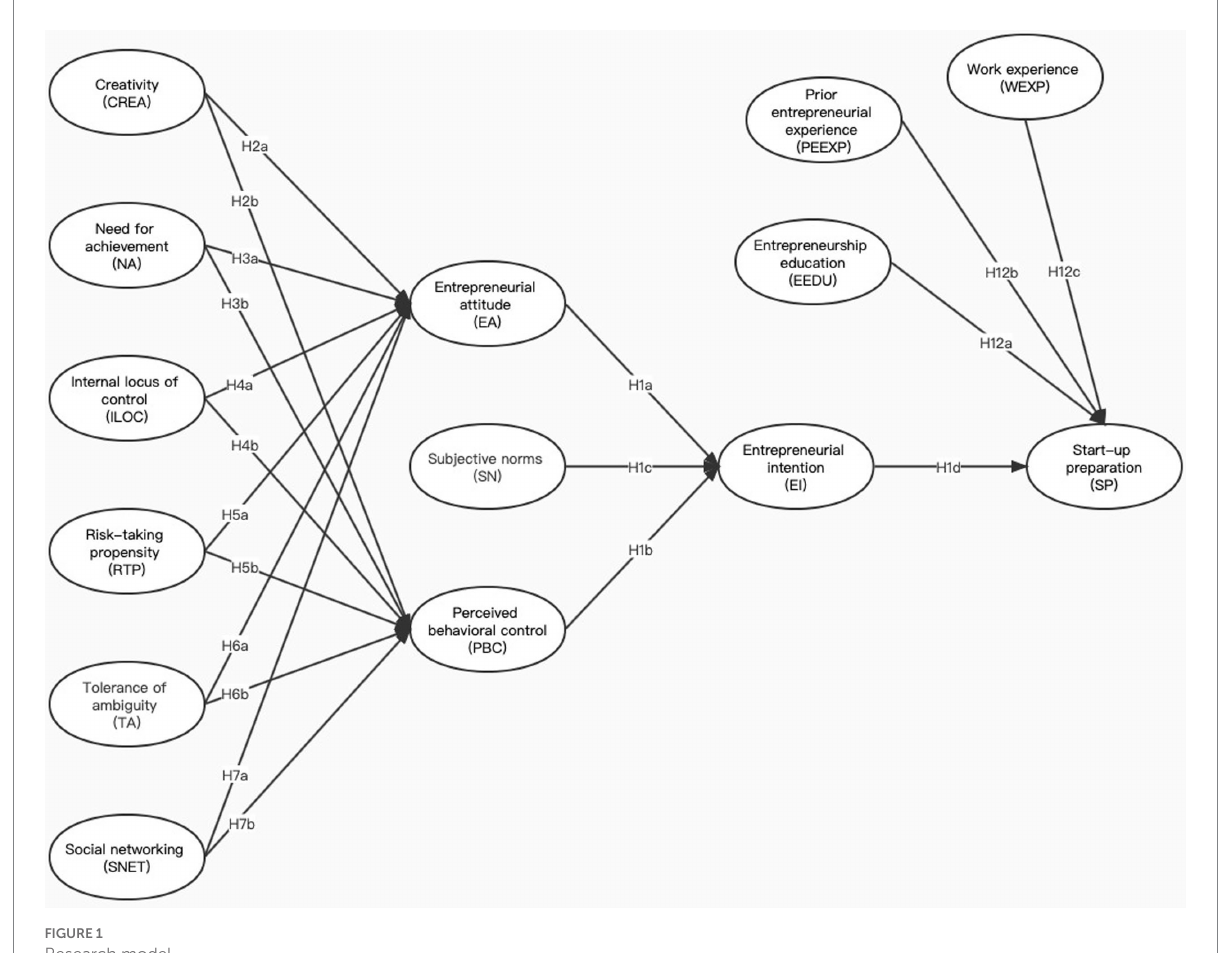
FIGURE 1 Research